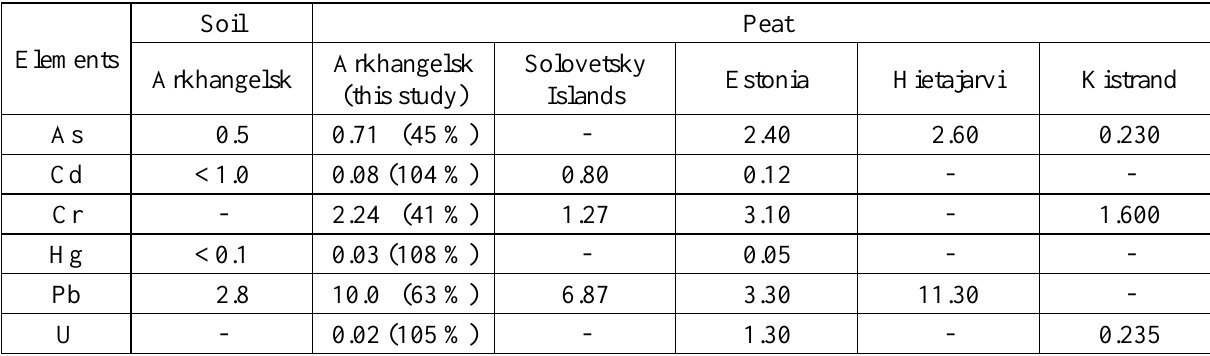
Table 4. Median concentrations of elements (mg kg -1 ) and CV (%) values determined in this study (see Table 3) in comparison with average concentrations of elements reported in the literature for soils in Arkhangelsk region (Popova 2014) and for peat in the Russian Solovetsky Islands (Kozioł et al . 2020) as well as in other European countries: Estonia (Orru & Orru 2006); Hietajarvi, Finland (Ukonmaanaho et al . 2004); and Kistrand, Norway (Frontasyeva & Steinnes 2005).